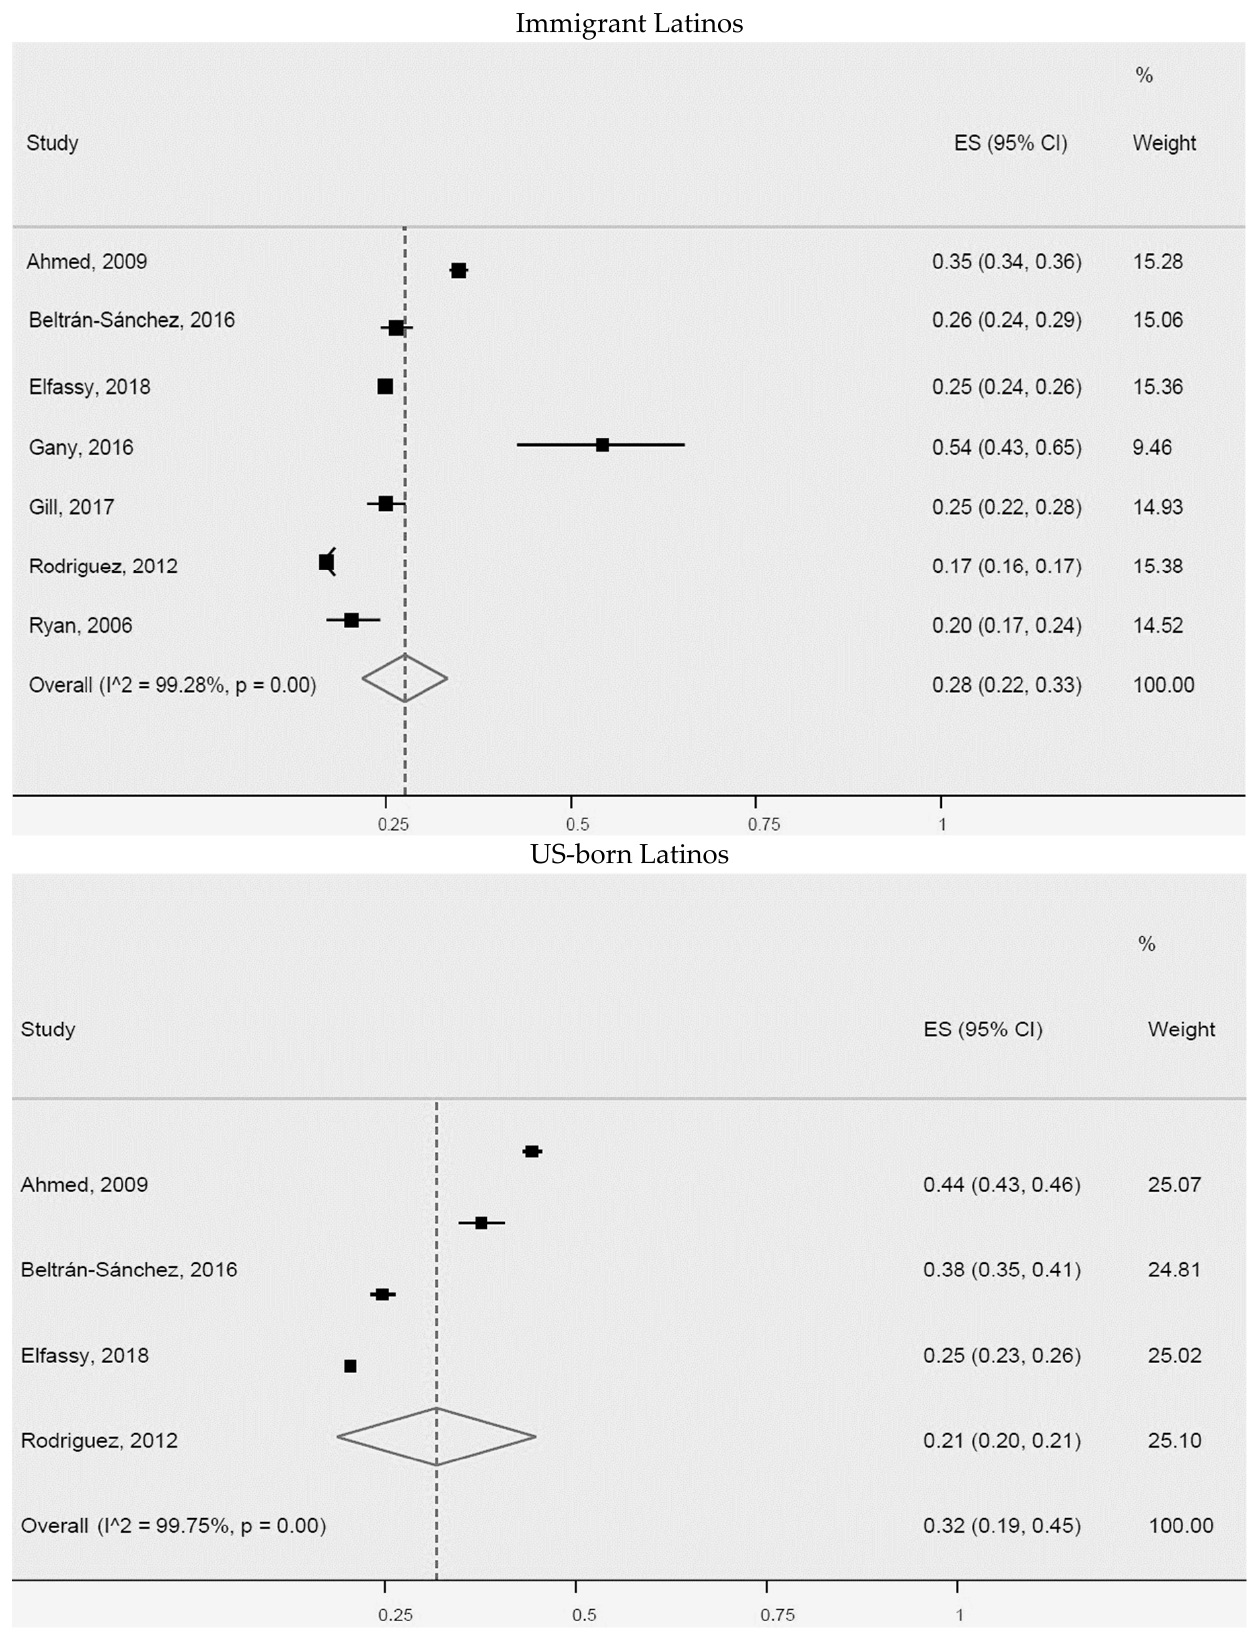
Figure 3. Arterial hypertension or high blood pressure for immigrant Latinos and US ‐ born Latinos. ES = Estimated proportion/prevalence; CI = Confidence interval; I^2 = I 2 index.